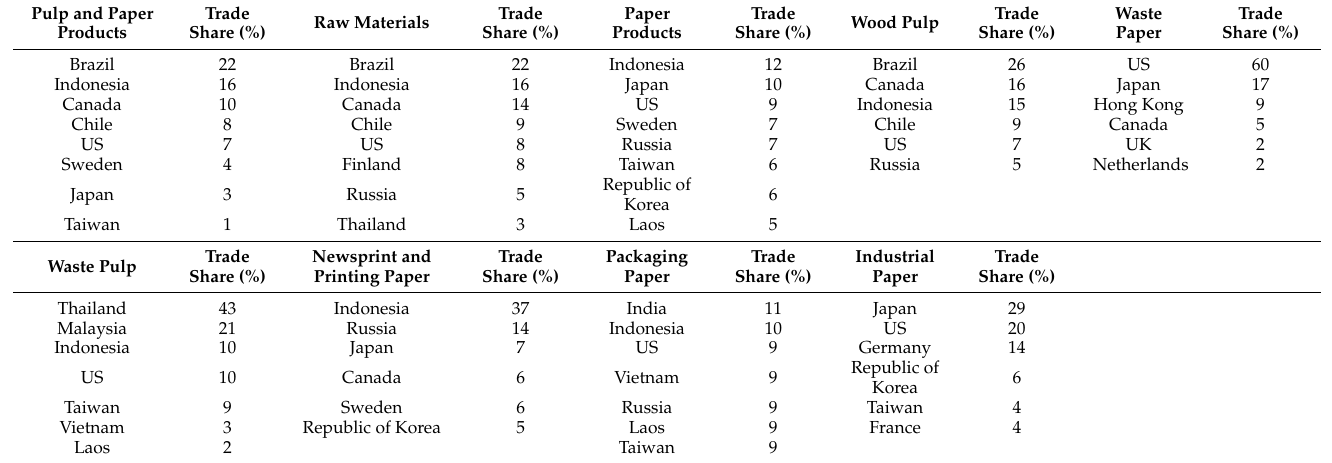
Table 1. Major trading partners selected and trade share in